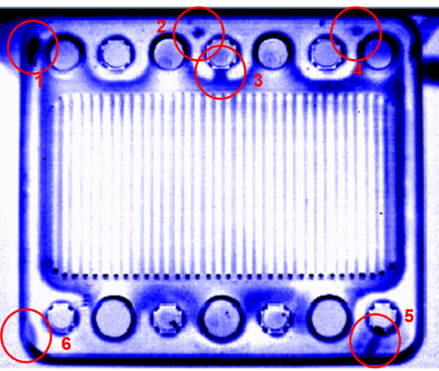
Figure 9. Thermographic phase image of a cell element obtained by flash excited thermography with internal defects as described in Figure 4.